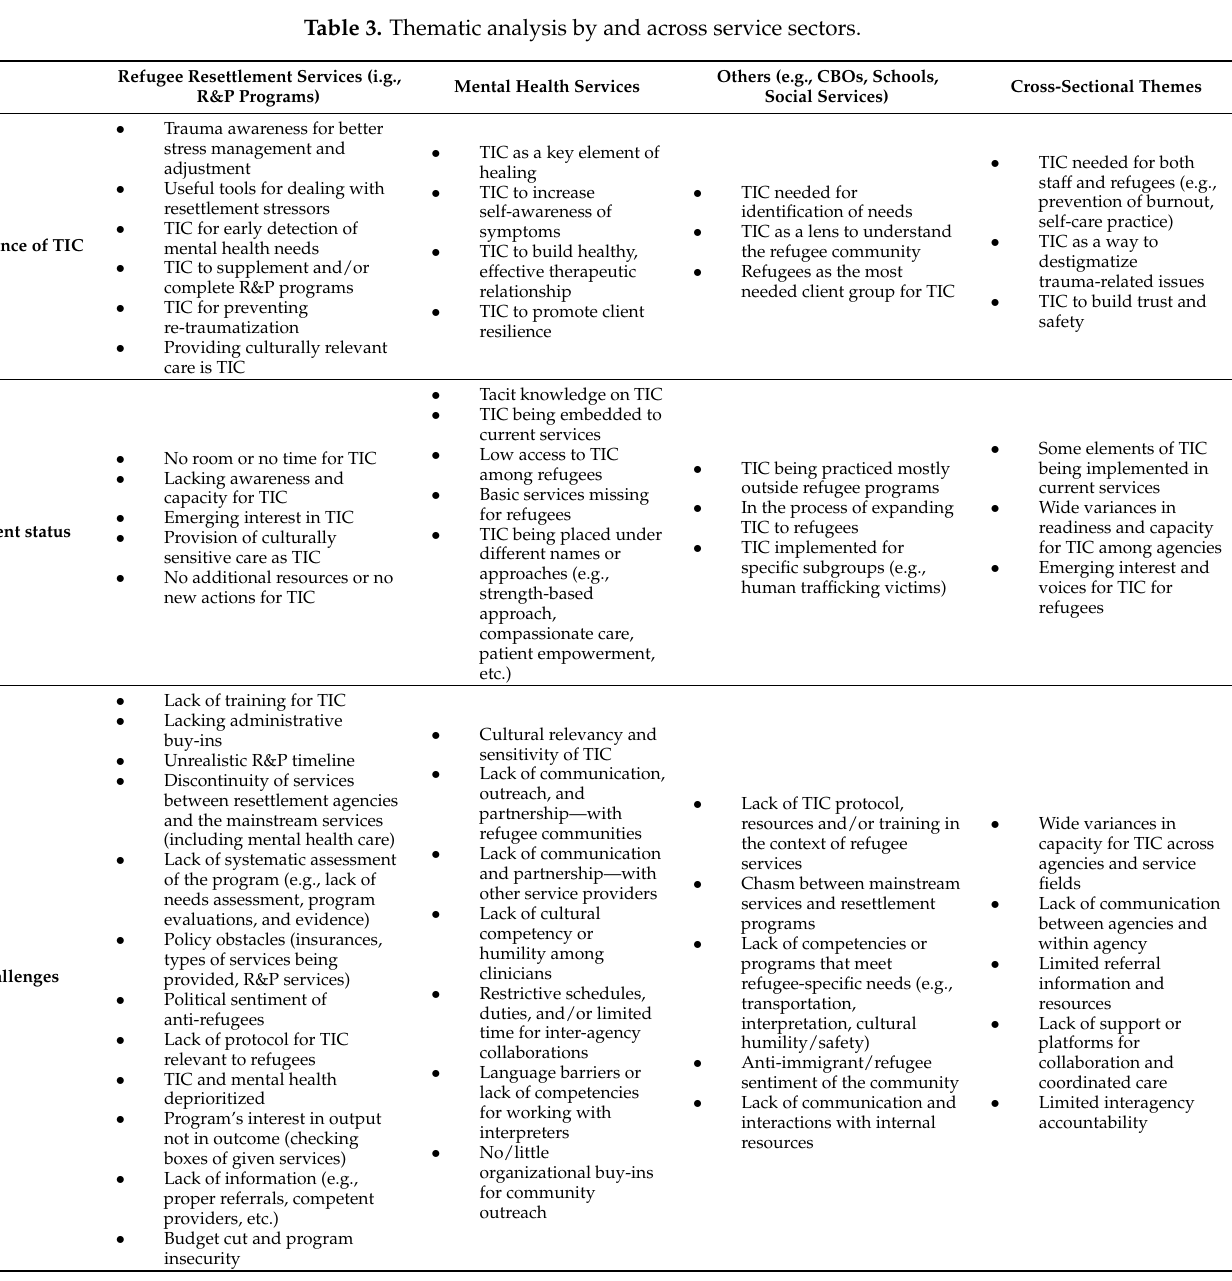
Table 3. Thematic analysis by and across service